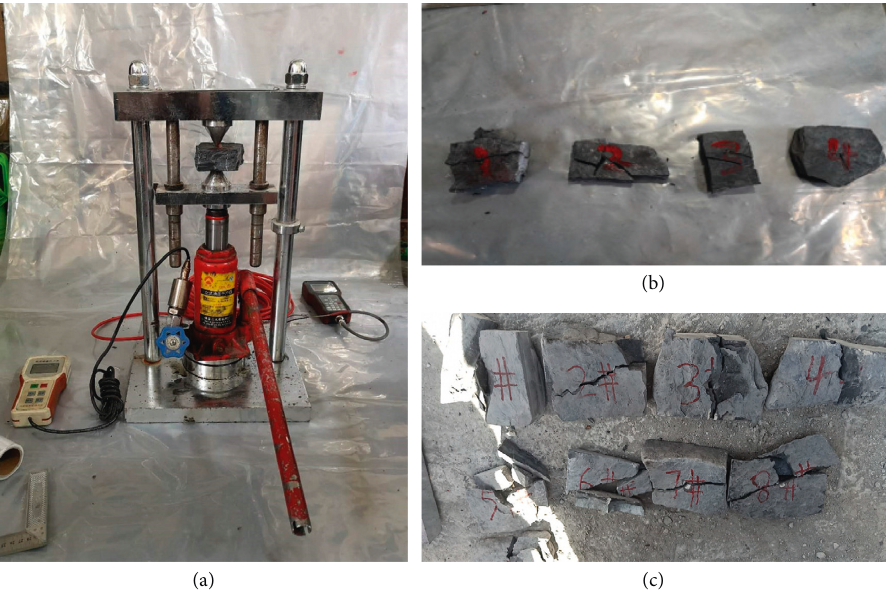
Figure 6: Laboratory instruments and some samples.